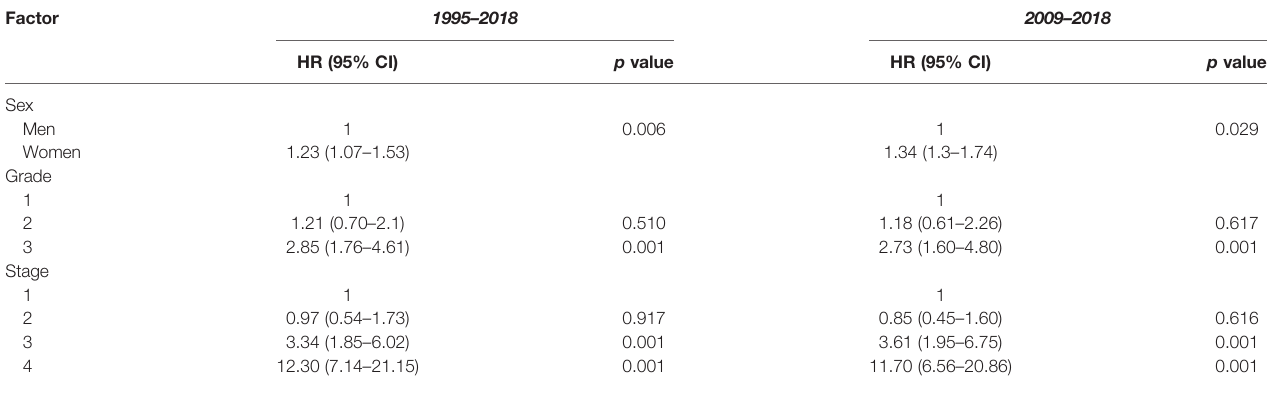
TABLE 4A | Hazard ratio (Univariate – Cox regression analyses).